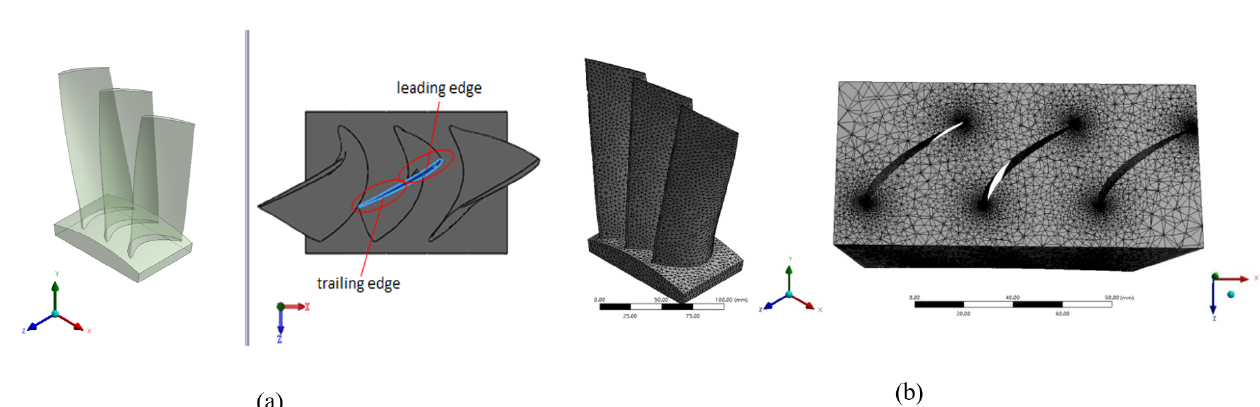
Figure 1. Analysis models and meshes of the blades. (a) Blade model and the (b) mesh of the blade with the flow field model. Table 1. Settings of the computational fluid dynamics (CFDs) analysis. Solver Type Pressure based Velocity formulation Absolute Time Steady Model Viscous Renormalization group (RNG) k-epsilon; standard wall functions Solution methods Pressure–velocity coupling scheme Simple Spatial discretization Gradient Least squares cell based Pressure PRESTO! Momentum Second-order upwind Volume fraction First-order upwind Turbulent kinetic energy First-order upwind Solution controls Under-relaxation factors Pressure 0.3 Density Body